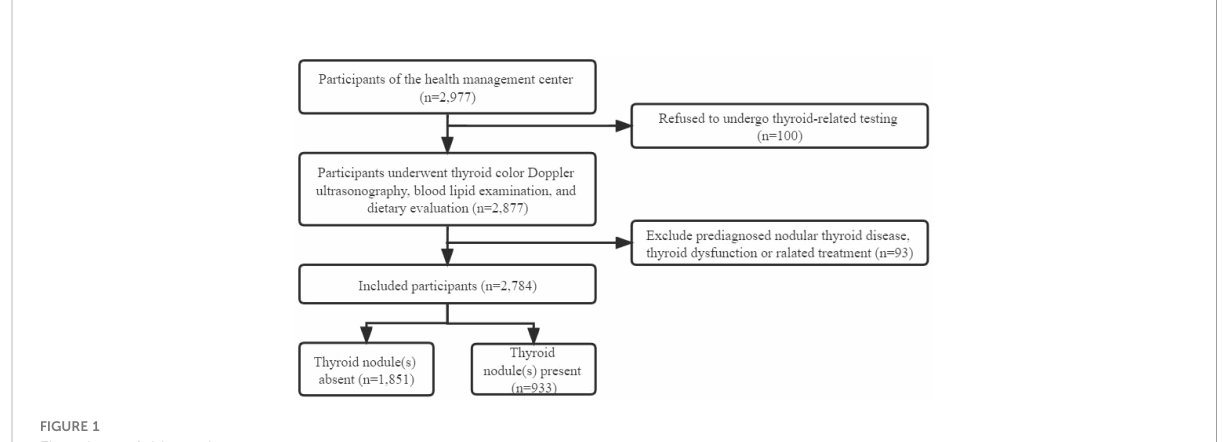
FIGURE 1 Flowchart of this